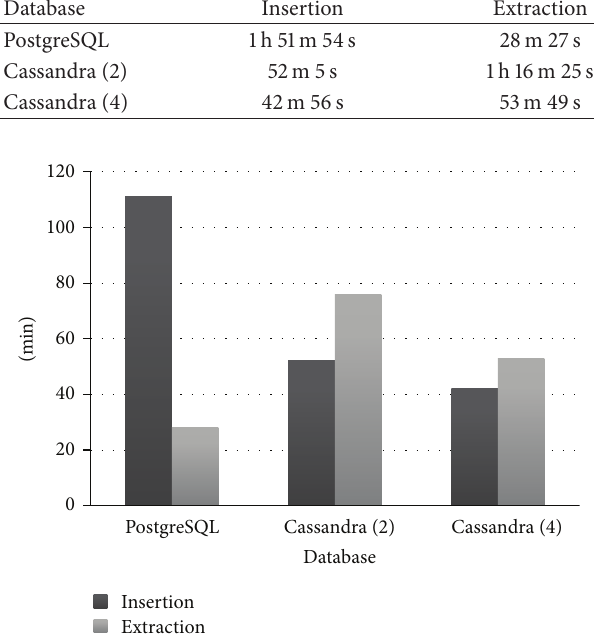
Figure 7: Comparison between Cassandra and MongoDB